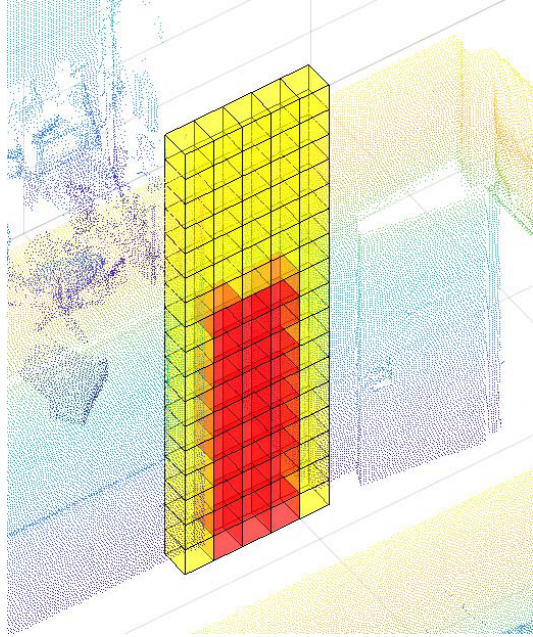
Figure 11. Occupied ( yellow ) and empty ( red ) voxels in the recognized door.